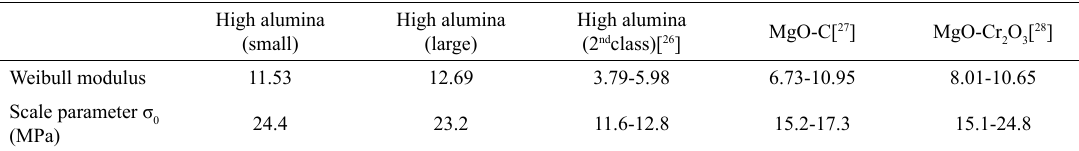
Figure 3. Weibull distribution curve of failure probability of high alumina bricks Table 2. Comparison of Weibull modulus and scale parameter of